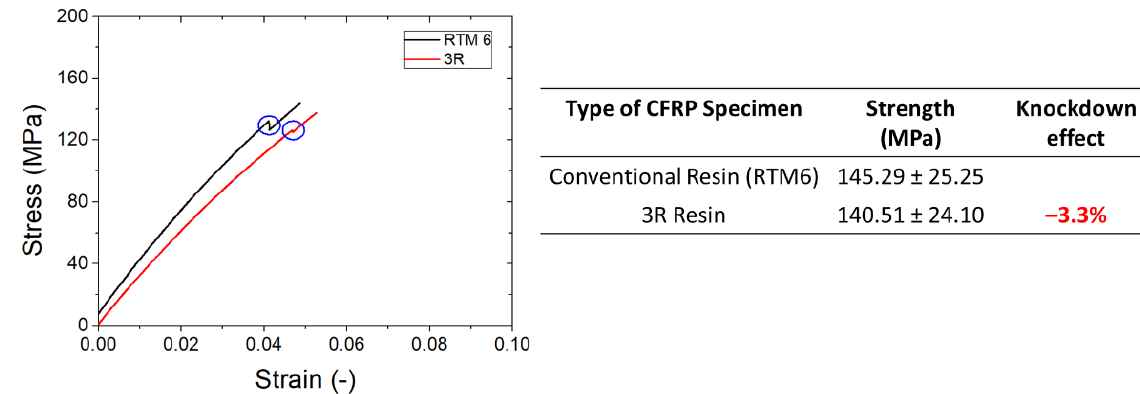
Figure 24. Representative stress – strain plots ( left ) and knockdown effect values ( right ) of lap strap specimens.